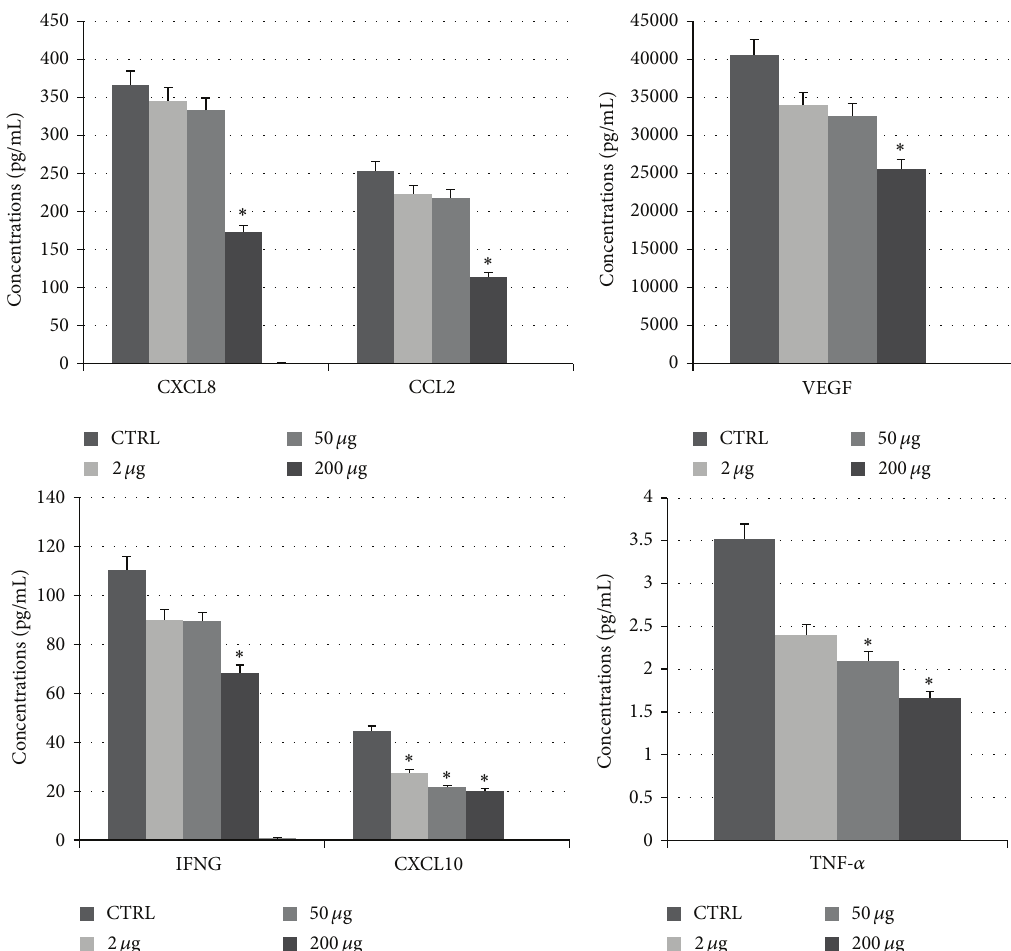
Figure 2: Statistically significant cytokine levels (expressed in pg/mL) evaluated in MCF-7 cells before and after treatment with different concentrations of sponge extract. Asterisks ∗ indicate the statistically significant differences between levels of untreated (used as controls and indicated with CTRL) and treated cells with 𝑃 < 0.05 using the 𝑡 -test. In the legend, we report the meaning of the bars by using different colors for untreated cells (CTRL) and three different treatments. In detail, we report CXCL8 (C-X-C motif ligand 8), CCL2 (C-C motif ligand 2), VEGF (vascular endothelial growth factor), IFNG (interferon gamma), CXCL10 (C-X-C motif ligand 10), and TNF- 𝛼 (tumor necrosis factor